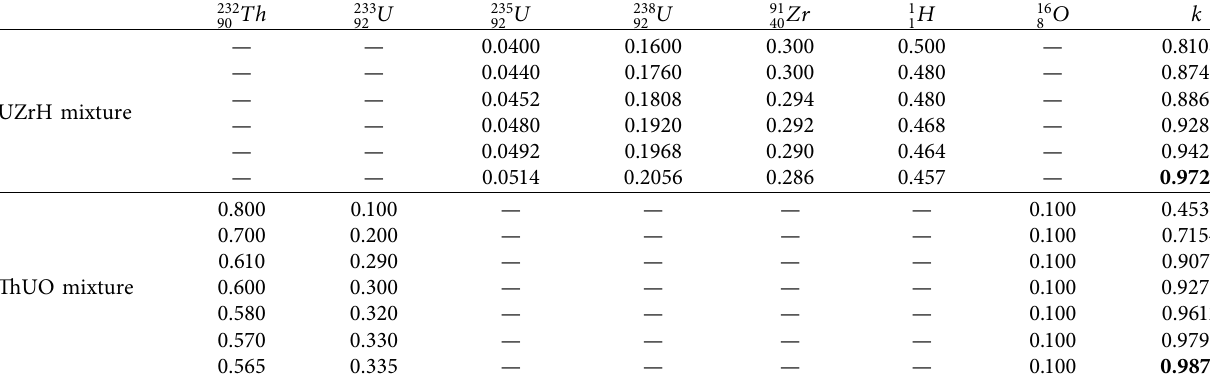
Table 3: Details of the ratio of components in the fuel mixture and calculation results of